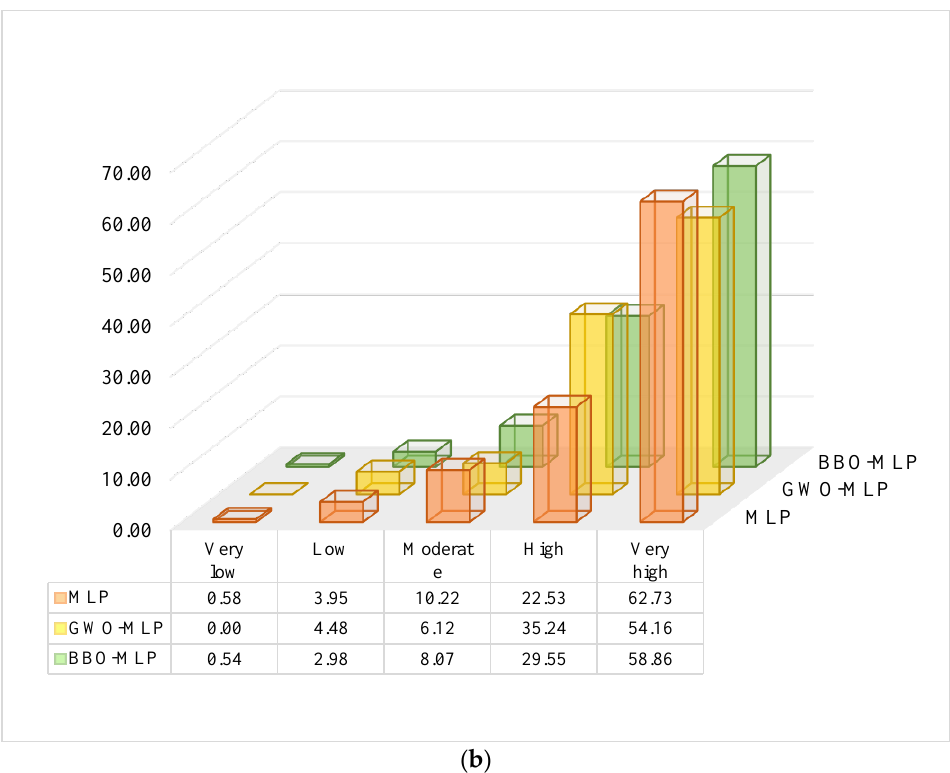
Figure 11. The percentage of the ( a ) training and ( b ) testing landslides located in each susceptibility class.